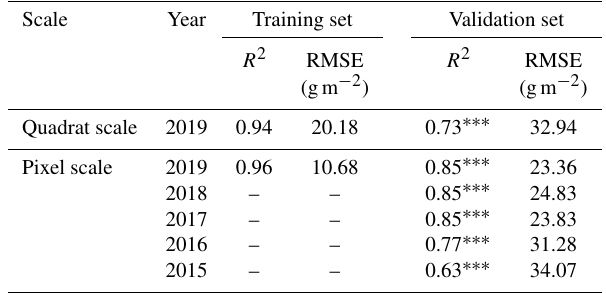
Table 3. Validation results of AGB models at the quadrat and pixel